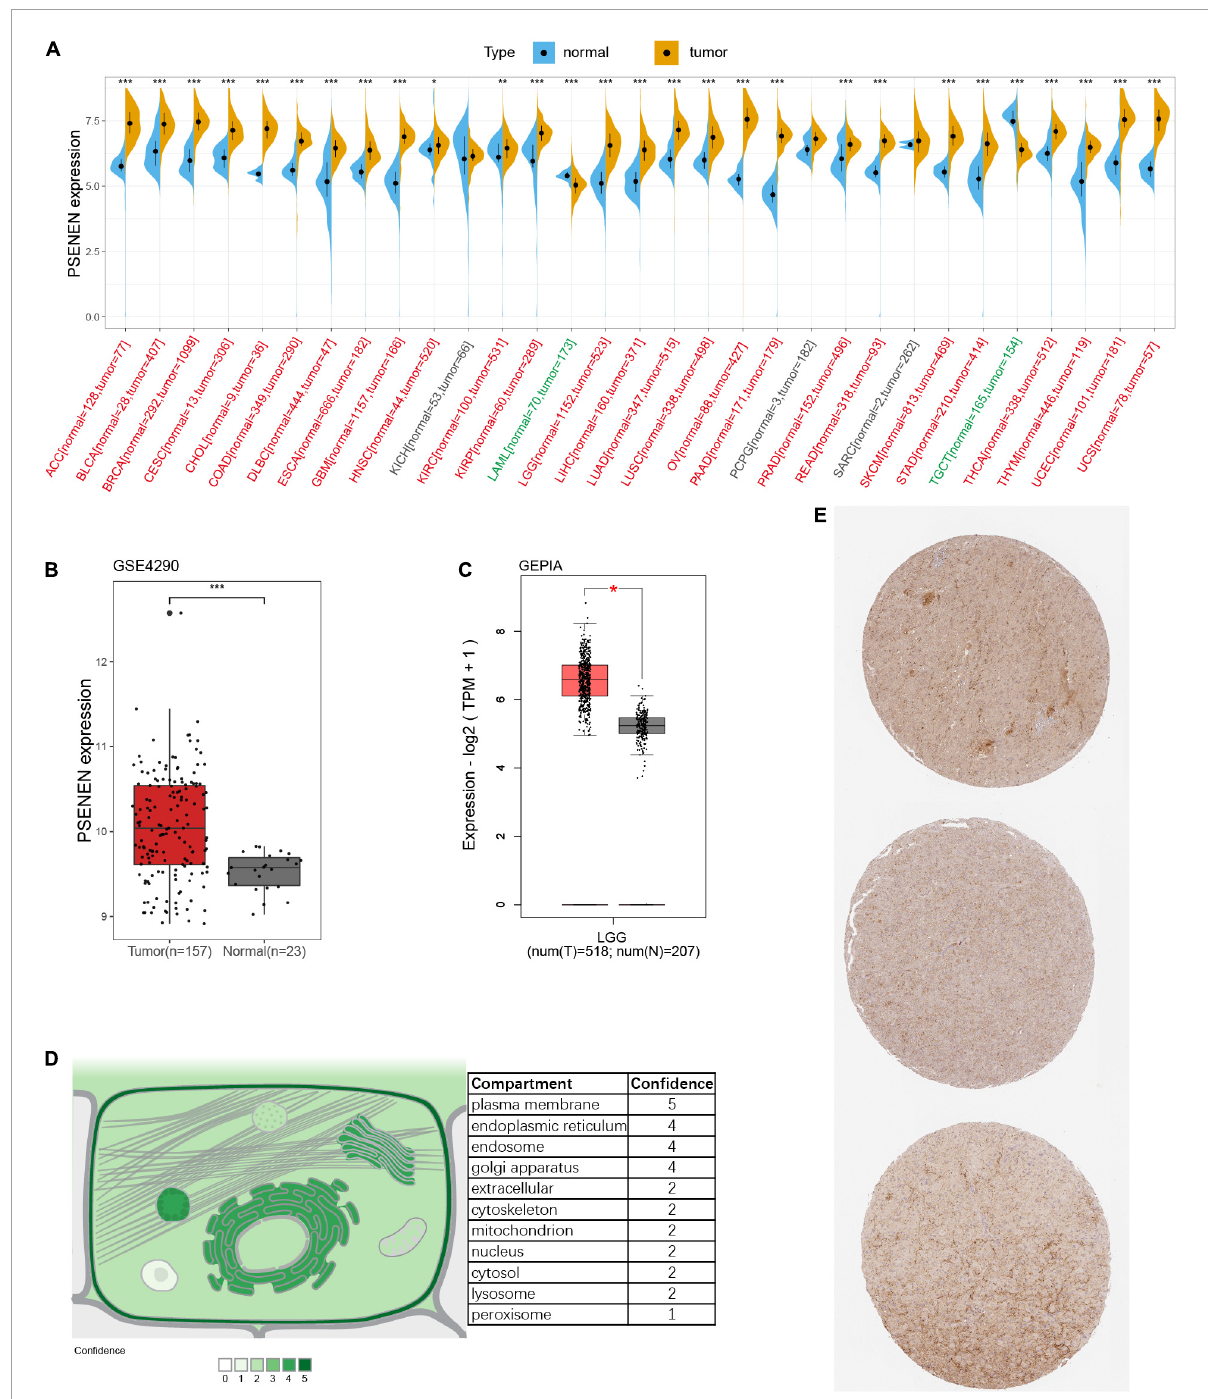
FIGURE1 Gene expression and protein information of PSENEN. (A) Differential expression of PSENEN in normal and tumor samples from patients with 31 types of cancers. Read labels on the x -axis represent an elevated expression of PSENEN in tumors compared to normal tissues, while green labels represent diminished expression, and black labels indicate no significant difference. PSENEN expression in LGG was examined by using the GSE4290 dataset (B) and GEPIA database (C) . (D) Subcellular locations of PSENEN from the COMPARTMENTS database. (E) Representative PSENEN immunohistochemical staining in LGG tissues. “*”, “**” and “***” indicate p < 0.05, p < 0.01, and p < 0.001,